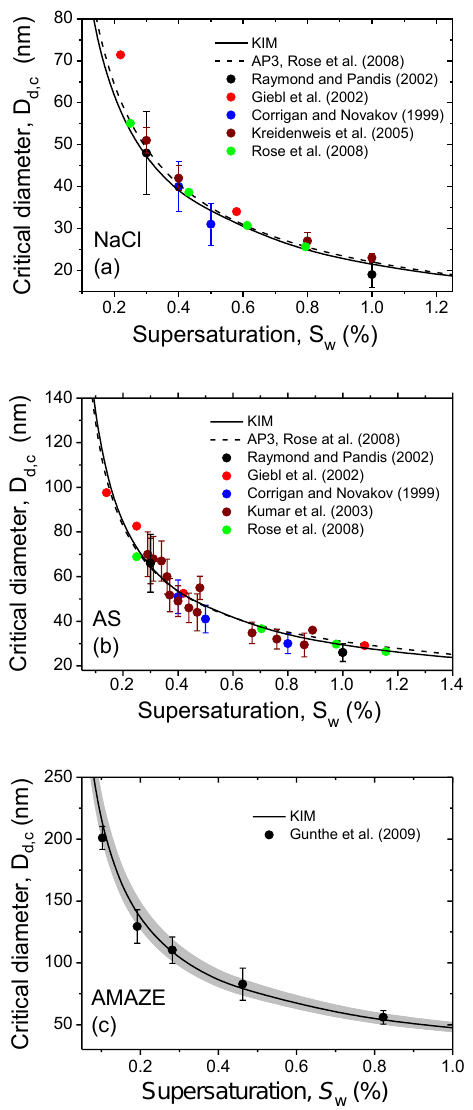
Figure 7: Critical dry diameters of CCN activation for sodium chloride (NaCl), ammonium sulfate (AS) and atmospheric aerosol samples (AMAZE) as a function of water vapor supersaturation according to Köhler theory. Solid lines are KIM model predictions based on FDHA measurement results ( κ 0 m inserted in Eq. 15). (a, b) Predictions for NaCl and AS are compared against a detailed reference model (dashed lines: AIM/AP3, Rose et al., 2008) and literature data from HTDMA measurements (Kreidenweis et al., 2005) or direct CCN activation measurements (other studies). (c) Predictions for the Amazonian aerosol sample (AMAZE) are compared against CCN measurement data recorded while the filter sample was collected (arithmetic mean ± standard deviation). The gray shaded area denotes the uncertainty range of prediction related to particle density: center line assuming ρ d = 1 . 3gcm − 3 , top bound with ρ d = 1 . 0gcm − 3 and low bound with ρ d = 1 . 6gcm − 3